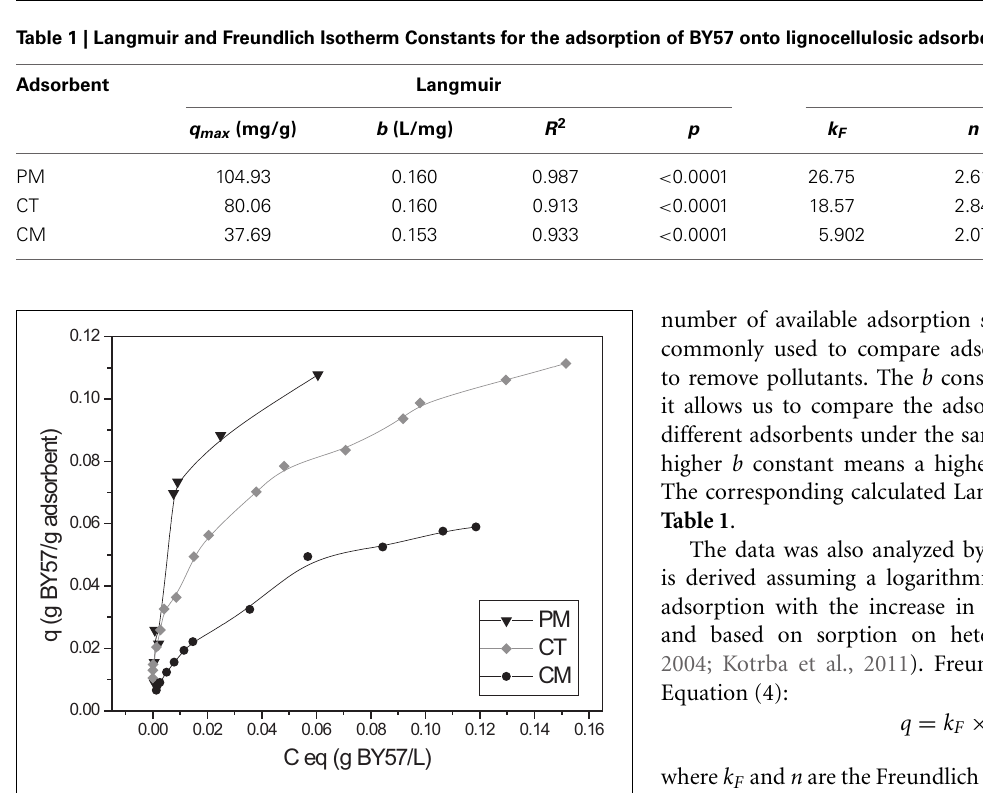
FIGURE 6 | Effect of large heavy metal cations on the adsorption of BY57. Copper effect ( left ) and zinc and lead effect ( right ).